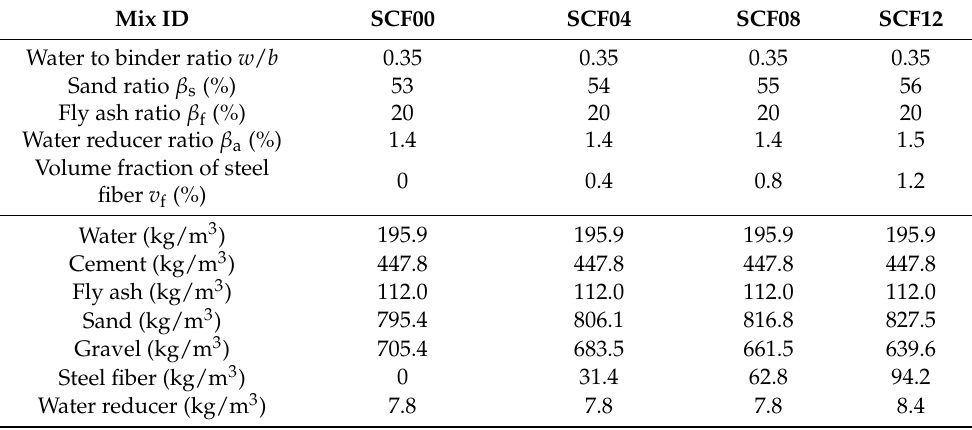
Table 4. Mix proportion of self-compacting SFRC.